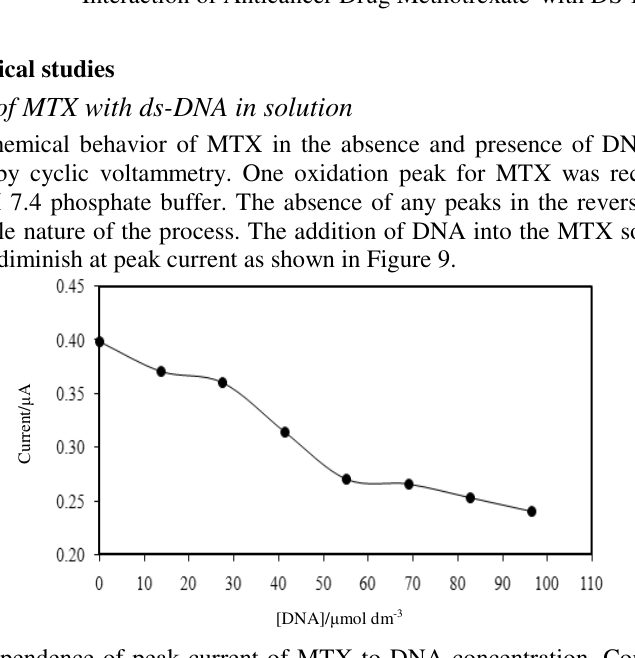
= DNA = 50.0 µ mol L -1 , ν = 20.0 mV s MTX